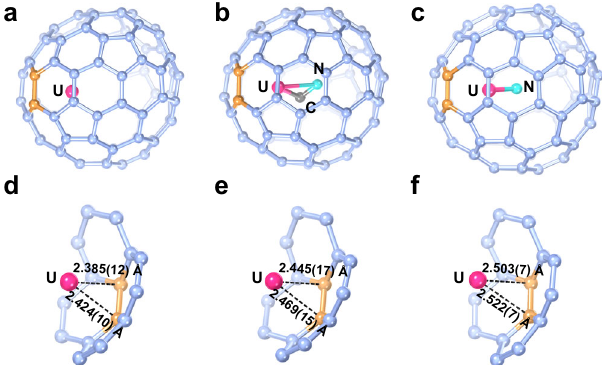
Fig.2|StructuresanddistancesbetweenUandthefullerenecage.a , d U@ C s (6)- C 82 , b , e UCN@ C s (6)-C 82 , and c , f UN@ C s (6)-C 82